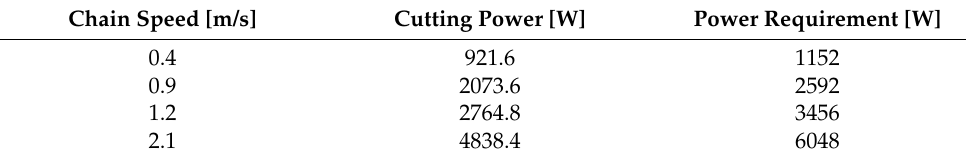
Table 3. Cutting forces and cutting powers. The chip area is a constant A chip = 8 mm 2